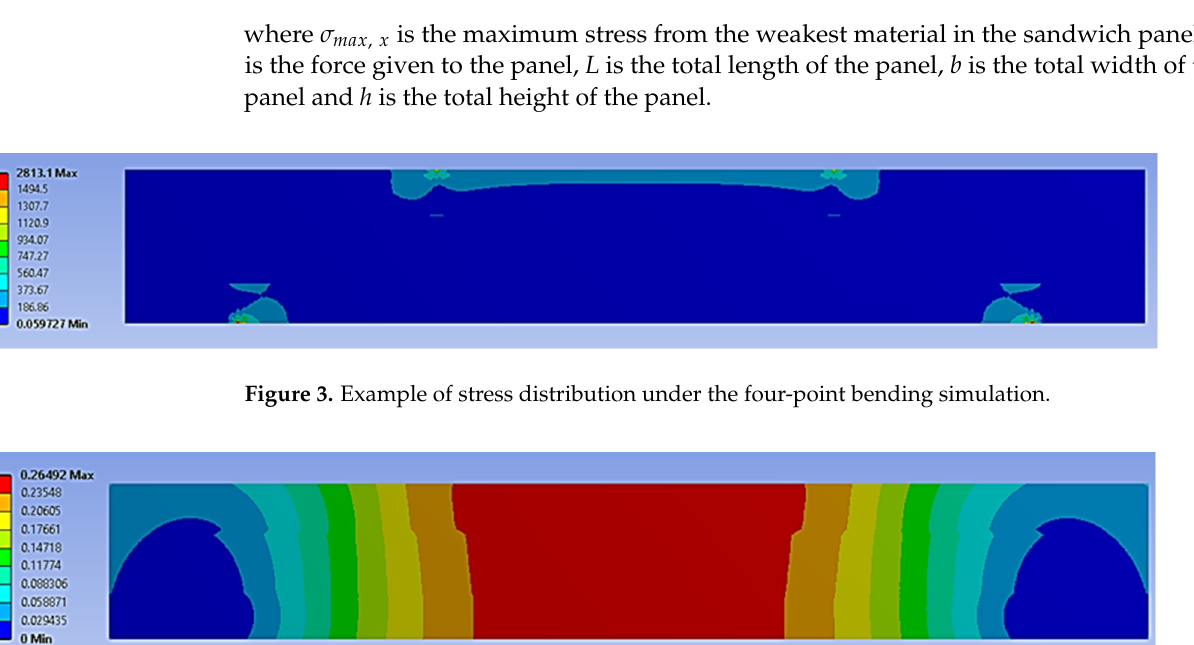
Figure 4. Example of total deformation distribution under the four-point bending simulation.